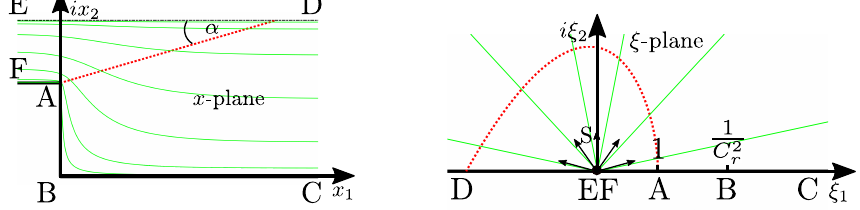
Figure 2. Illustration of the Schwarz–Christoffel mapping (not to scale). Mean flame position ( ) and straight lines radiating from the origin of the image domain ( ), each in the physical domain ( left ) and the image domain ( right